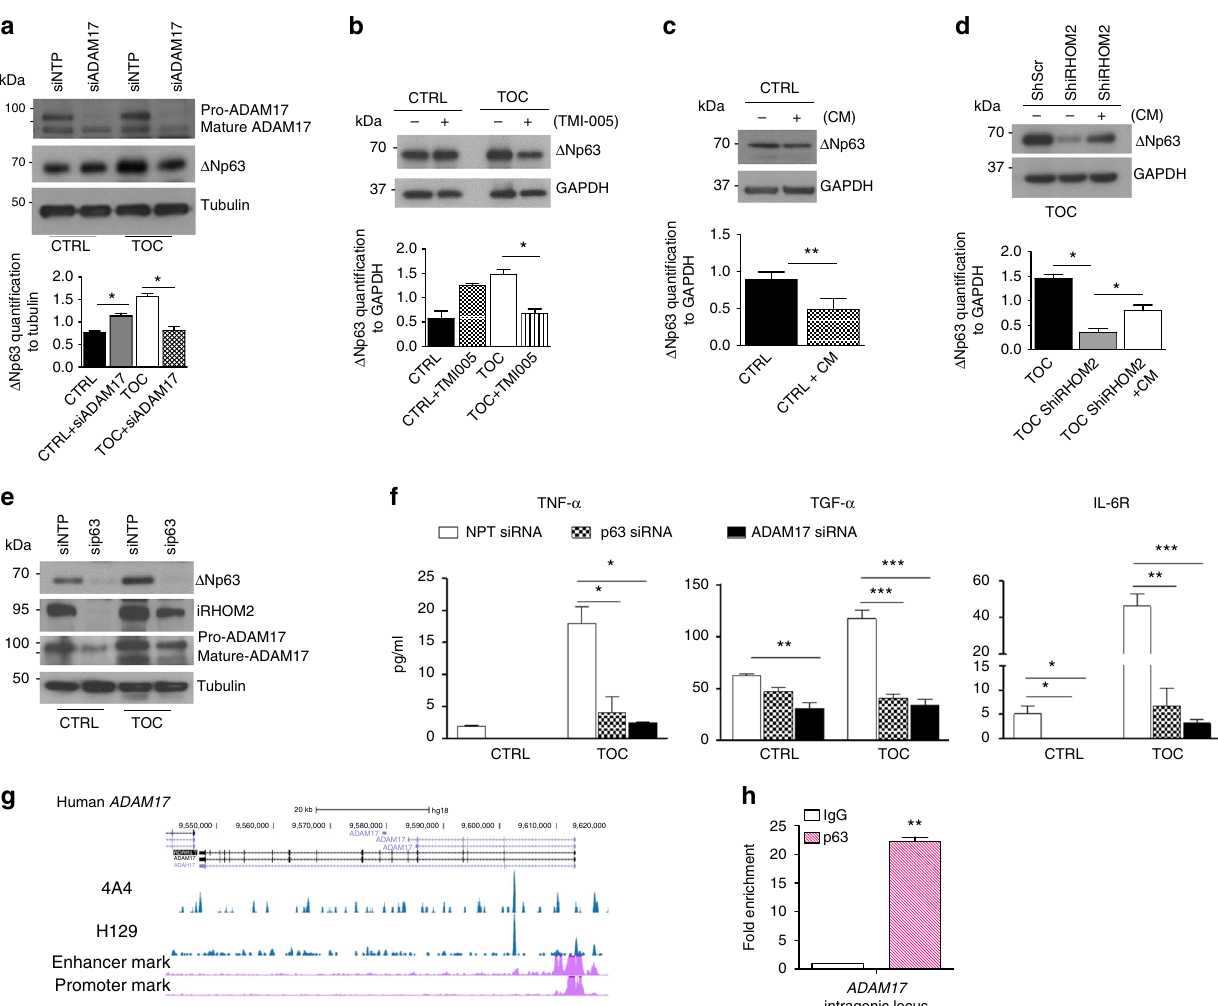
Fig. 3 iRHOM2 – ADAM17 axis regulates p63 expression. a Expression of ADAM17 and Δ Np63 by WB in control (CTRL) and TOC keratinocytes transfected with non-targeting pool (NTP) and ADAM17 siRNA. b Immunoblotting of Δ Np63 expression performed in CTRL and TOC keratinocytes treated with and without TMI-005 for 24 h. c Immunoblotting for Δ Np63 in CTRL keratinocytes and d in Sh Scr (Scramble) and Sh iRHOM2 TOC keratinocytes treated with or without conditioned media (CM) for 24 h. GAPDH was used as a loading control. e WB analysis for Δ Np63, iRHOM2 and ADAM17 in normal and TOC keratinocytes with NTP and p63 siRNA. TUBULIN was used as a loading control. All the quanti fi cations included were performed by ImageJ software in comparison to the loading control in three independent experiments. Student ’ s t test was used, (* p < 0.05 and ** p < 0.01). f Levels of TNF α , TGF α and IL-6R were assessed by ELISA from the supernatant of NTP, p63 and ADAM17 siRNAs in CTRL and TOC keratinocytes. Data are expressed as mean with SEM from four experiments. Statistical analysis was compared to NTP siRNA CTRL or TOC using one way ANOVA Dunnett ’ s multiple comparison test (* p < 0.05, ** p < 0.01 and *** p < 0.001). g Screenshot of the UCSC genome browser from ChIP-seq analysis of normal human primary keratinocytes with two different antibodies (4A4, pan-p63 and H129, α -speci fi c). The ChIP-seq study was previously reported. h Chromatin immunoprecipitation in control keratinocytes (CTRL) with anti-pan p63 (H137) and anti-IgG antibodies followed by quantitative PCR (ChIP-qPCR) analysis showed that p63 binds to ADAM17 intragenic region. Error bars represent SEM of three independent experiments. For statistical evaluation Student ’ s two-tailed t test was used (** p <